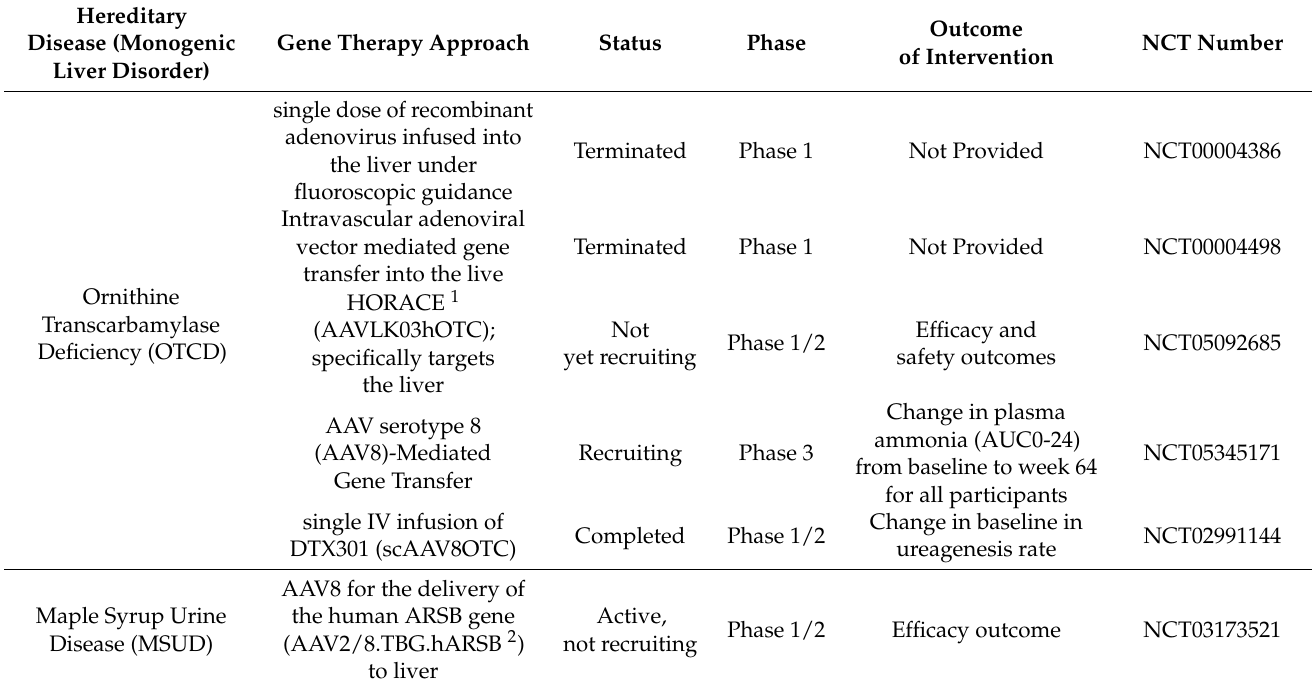
Table 2. Gene-therapy-based clinical trials in monogenic liver disorders.